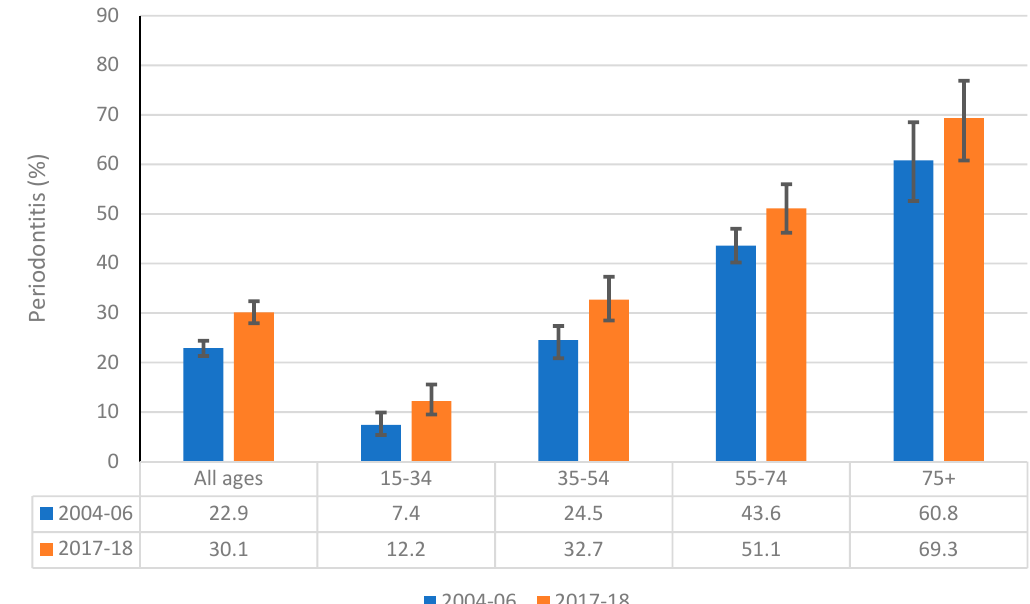
Figure 2. Trends in complete tooth loss among Australians aged 15 years and over, 1987–88, 2004–06 and 2017–18.